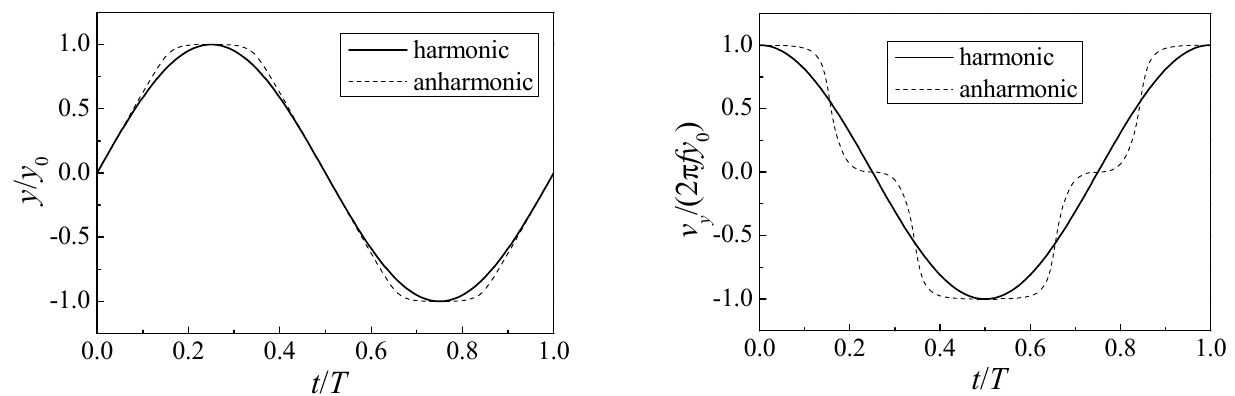
Figure 4. Harmonic and anharmonic ( n = 1) Y-direction displacement ( left ) and heave velocity curves ( right ).